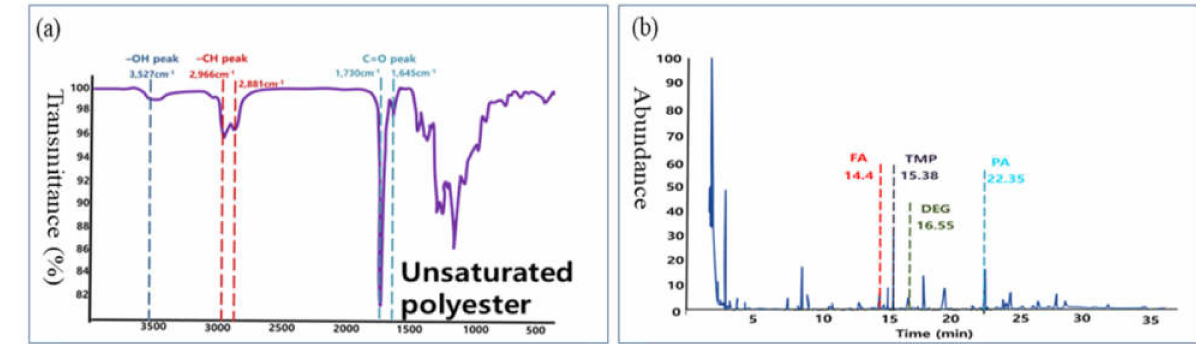
Figure 3. Analysis of UPR putty using ( a ) FTIR spectroscopy and ( b ) PyGCMS (FA: fatty acids; TMP: trimethylolpropane; PA: phthalic anhydride).